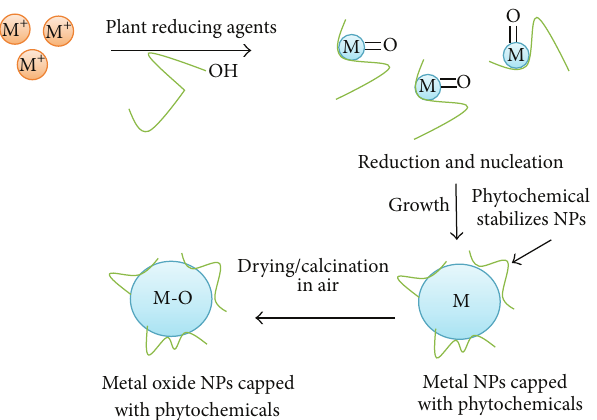
Figure1:Mechanismofplantmediatedsynthesisofmetalandmetal oxide